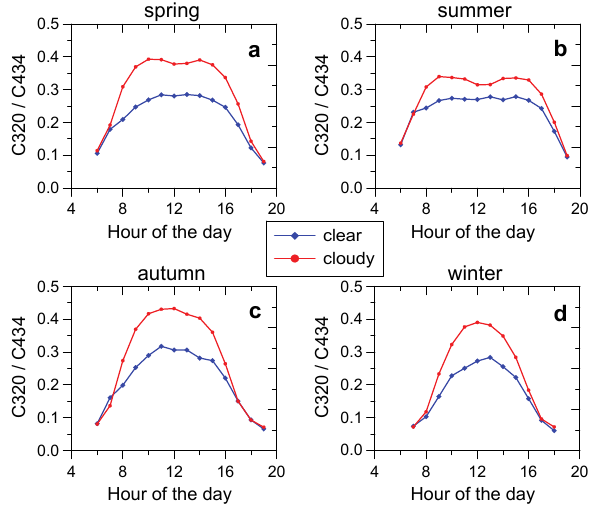
Fig. 13. Diurnal variations of the C320/C434 ratio under clear and cloudy conditions, averaged for different seasons from August 2008 to September 2011.